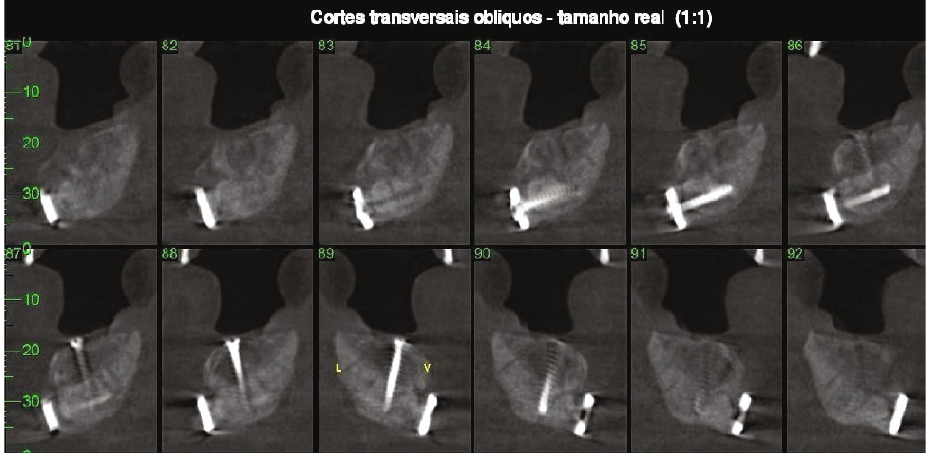
Figure 8: Postoperative computed tomography (6